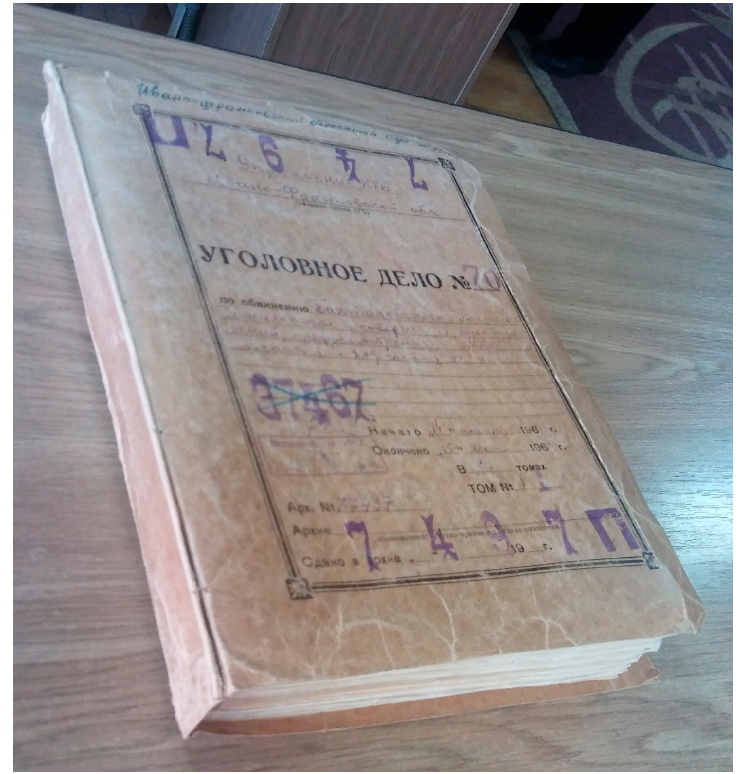
Figure A2. The criminal case (1968–1969) of Fr Roman Bakhtalovskyy.